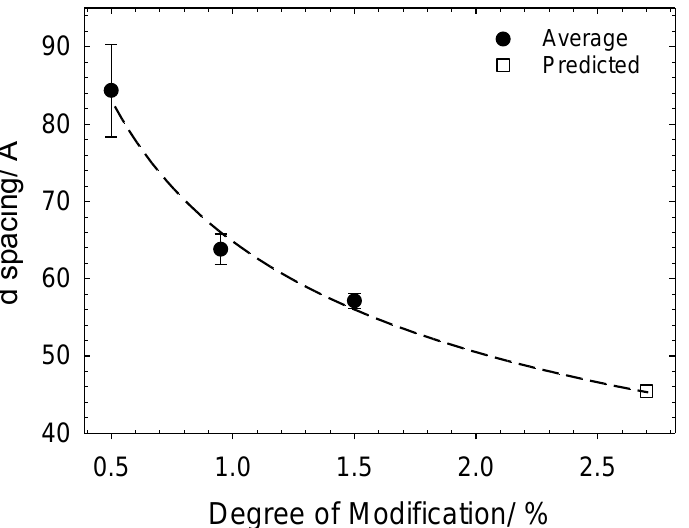
Figure 5. Change in d-spacing between surfactant complexes for the different cat-HEC PEs. Symbols: filled circles, averaged value; unfilled square, predicted